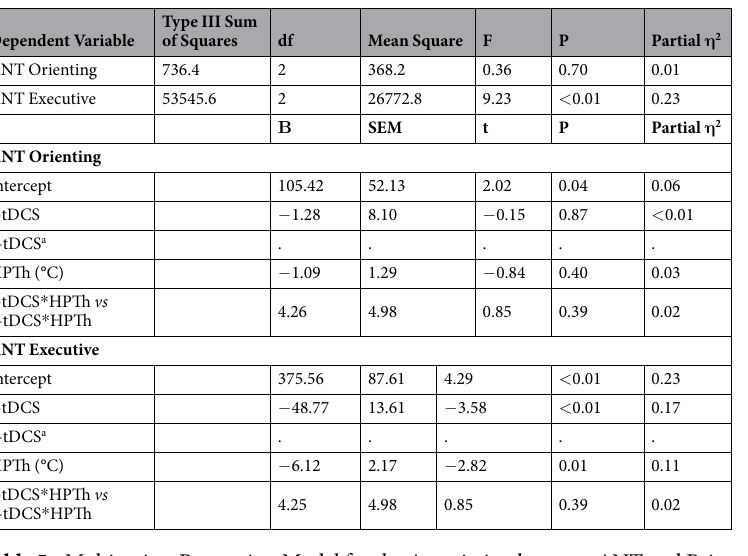
Table 5. Multivariate Regression Model for the Association between ANT and Pain measures and Group (a-tDCS + Go/no-Go Task vs. s-tDCS + Go/no-Go Task) (n = 35). Notes: HPTh = Heat Pain Threshold; df = degrees of freedom; SEM = standard error of the mean; η 2 = eta squared effect size index. a Comparative group, to which values are referenced to.